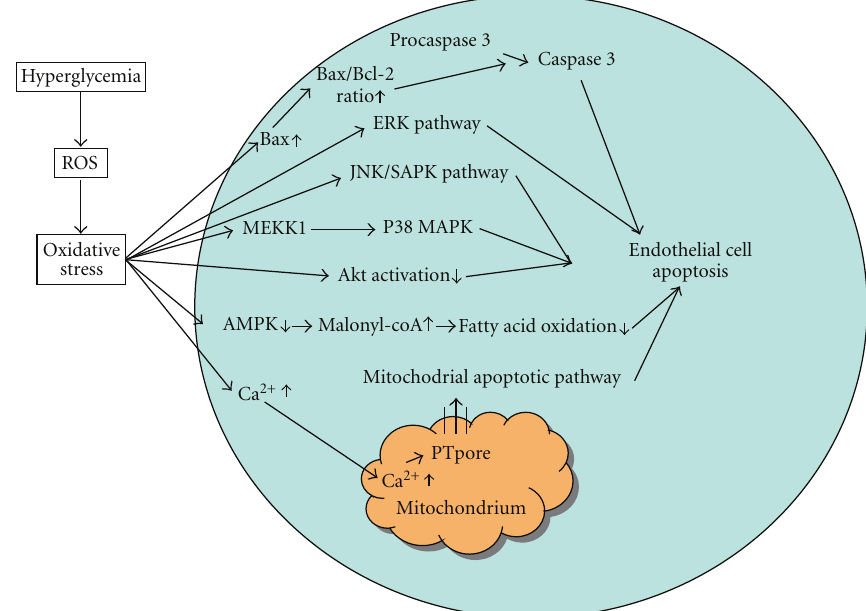
Figure 4: Mechanisms by which hyperglycemia is supposed to induce endothelial cell